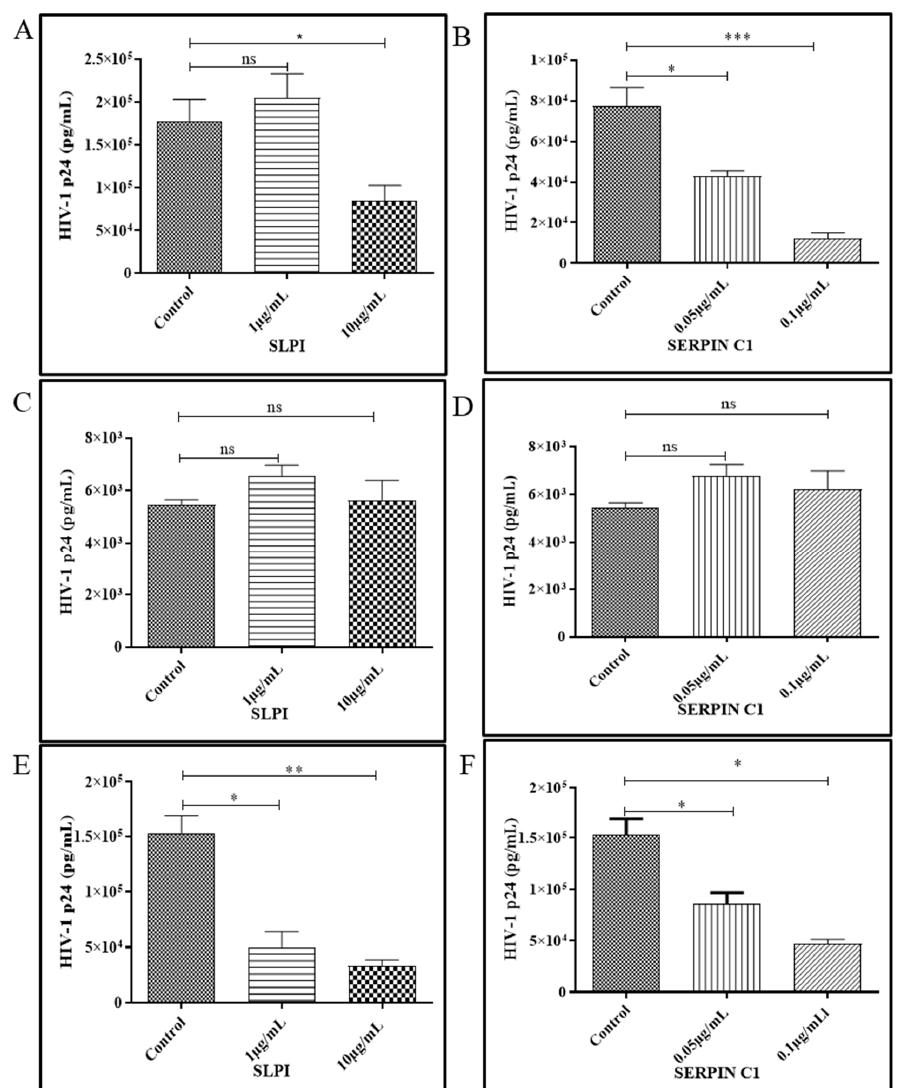
Figure 3. HIV-1 Replication in Pre-treated MDMs ( A , B ), Post HIV-1-infected MDMs ( C , D ) and MDMs infected with pre-incubated inoculum- ( E , F ) treated with SLPI and SERPINC1. ( A , B ) MDMs (1 × 10 6 cells/well) were pre-treated with ( A ) SLPI 1 μ g/mL and 10 μ g/mL or ( B ) SERPIN C1 0.05 μ g/mL and 0.1 μ g/mL concentration for 3 h then infected with HIV-1 BaL 5 ng/mL p24 units. After 2 h the virus was removed, and fresh culture media added with 1 μ g/mL and 10 μ g/mL SLPI or 0.05 μ g/mL and 0.1 μ g/mL SERPINC1 and cultured. ( C , D ) MDMs (1 × 10 6 cells/well) were infected with HIV-1 BaL 5 ng/mL p24 units. After 2 h, the virus was removed, and fresh culture media added with ( C ) SLPI 1 μ g/mL and 10 μ g/mL concentration or ( D ) SERPIN C1 0.05 μ g/mL and 0.1 μ g/mL and cultured the MDMs. ( E , F ) HIV-1 BaL (5 ng/mL p24 units) was incubated without or with ( E ) SLPI 1 μ g/mL and 10 μ g/mL or ( F ) SERPIN C1 0.05 μ g/mL and 0.1 μ g/mL at 37 °C for 2 h in PBS containing 0.1% BSA. After that, MDMs (5 × 10 5 cells/well) were infected with HIV-1 BaL and incubated at 37 °C for 2 h for virus adsorption washed with phosphate-buffered saline (PBS) and cultured in 2 mL fresh media at 37 °C. Culture supernatants were collected after 7 days post infection and HIV-1 replication quantitated by HIV-1 p24 ELISA. Culture supernatants were analyzed in triplicate. Results expressed as mean ± SEM. This data is representative of three independent donors. Asterisk (*) over the bars indicates significant difference with control, *** p < 0.0001; ** p < 0.001; * p ≤ 0.05 and ns p > 0.05. p -values were generated by one-way ANOVA with multiple comparisons